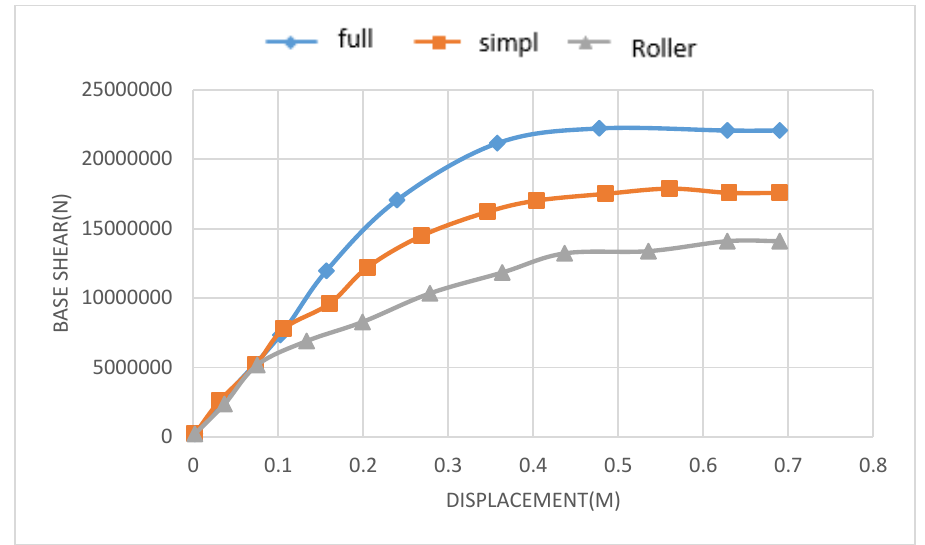
Fig. 17. 5 spans bridge with base height 6 meters in transverse direction.